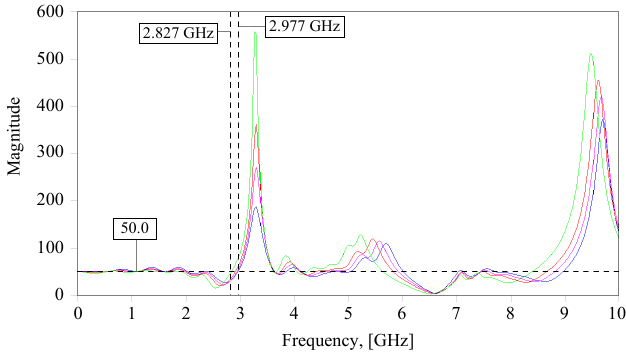
Fig. 3. Input impedance of the meander line, when a = 0.2 mm (blue); a = 0.4 mm (pink); a = 0.6 mm (red); a = 1 mm (green); Z 0 = 50 Ω .